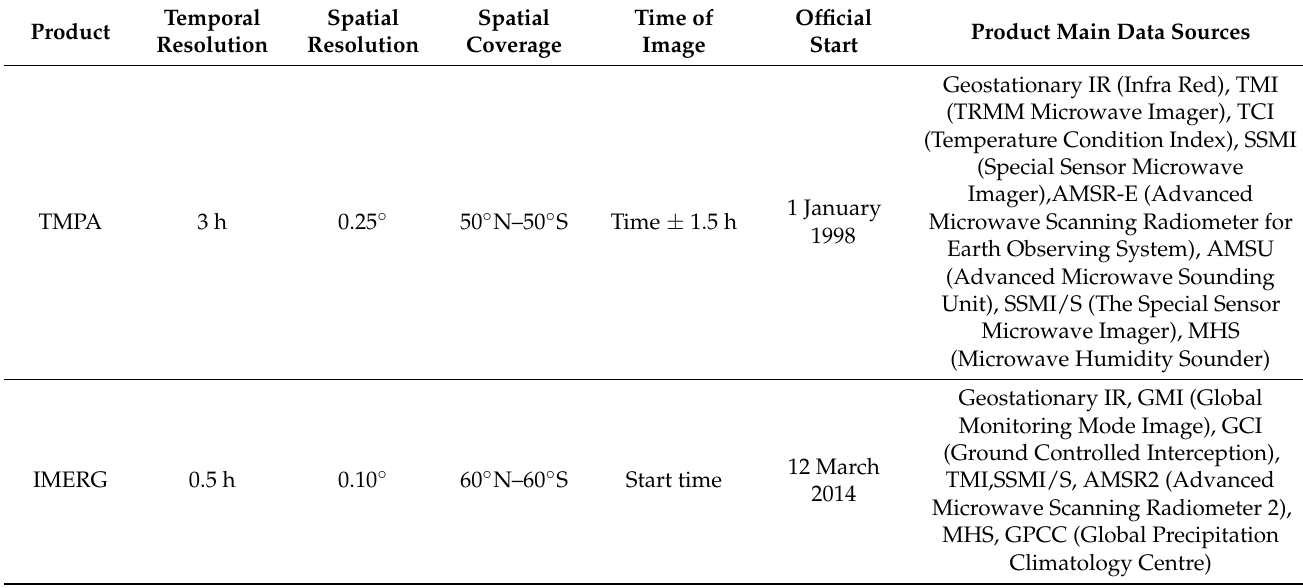
Table 1. Summary of the differences between TMPA and IMERG